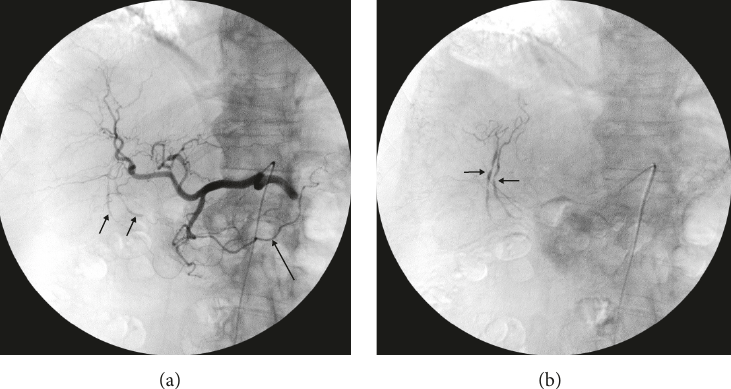
Figure 2: Digital subtraction angiograms. Common hepatic arteriogram (a) with the right gastroepiploic artery forming the omental arch (arrow) and two small right omental branches with multisegmental dilatation (small arrows), better visible in the late phase (b).